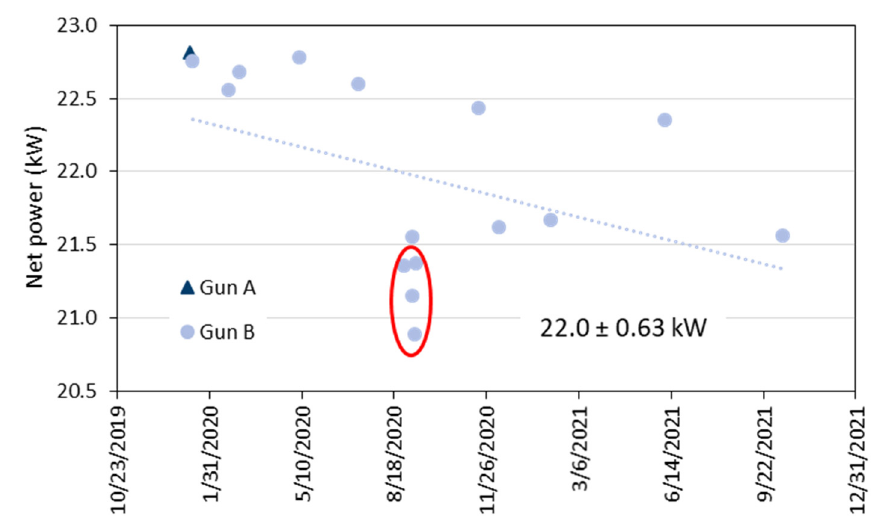
Figure 5. Variability of the torch net power obtained in the period of 2020 and 2021.